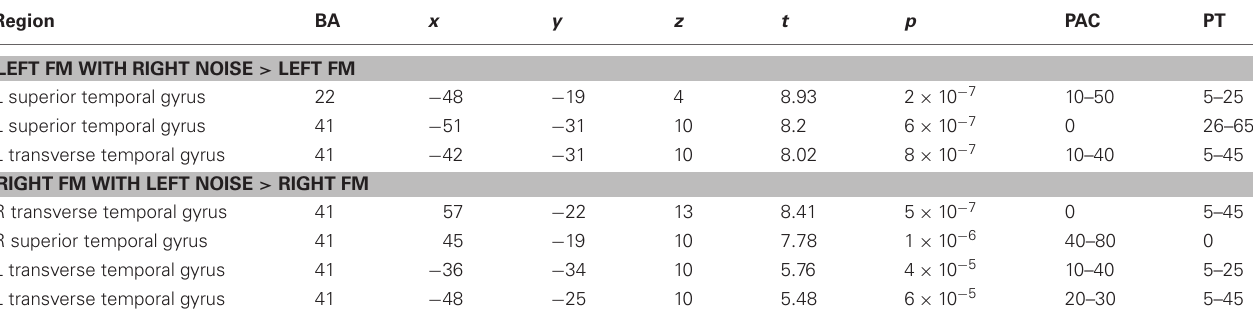
Table 1 | Peak points within regions with an increase of activity due to additional contralateral noise [BA-Brodmann area; x, y, z —Talairach coordinates, PAC—probability (%) to be localized in primary auditory cortex according to Rademacher et al. (2001), PT—probability (%) to be localized in planum temporale according to Westbury et al.